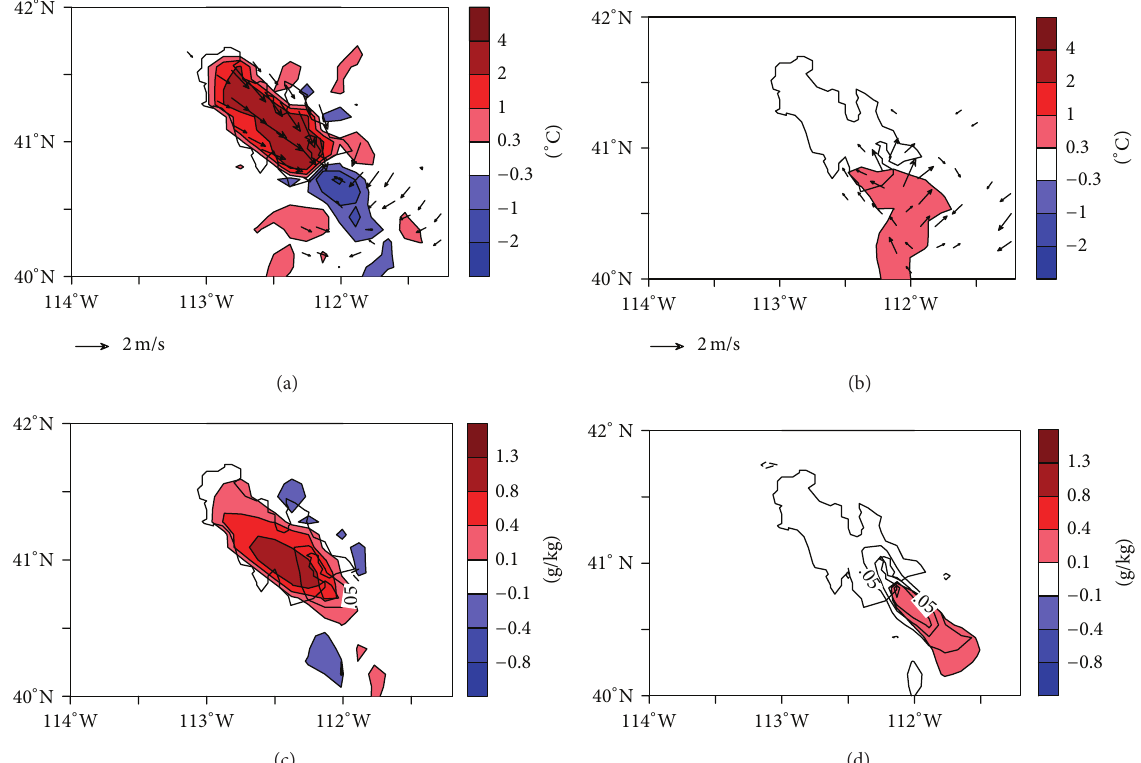
Figure 9: Simulated surface horizontal wind difference and difference of surface skin temperature (a), simulated horizontal wind difference and temperature difference over 700 hPa (b), simulated vertical wind difference over 800 hPa and simulated humidity difference near surface (c), and simulated vertical wind difference and humidity difference over 700 hPa (d) between SL and NL experiments in the first GSL precipitation